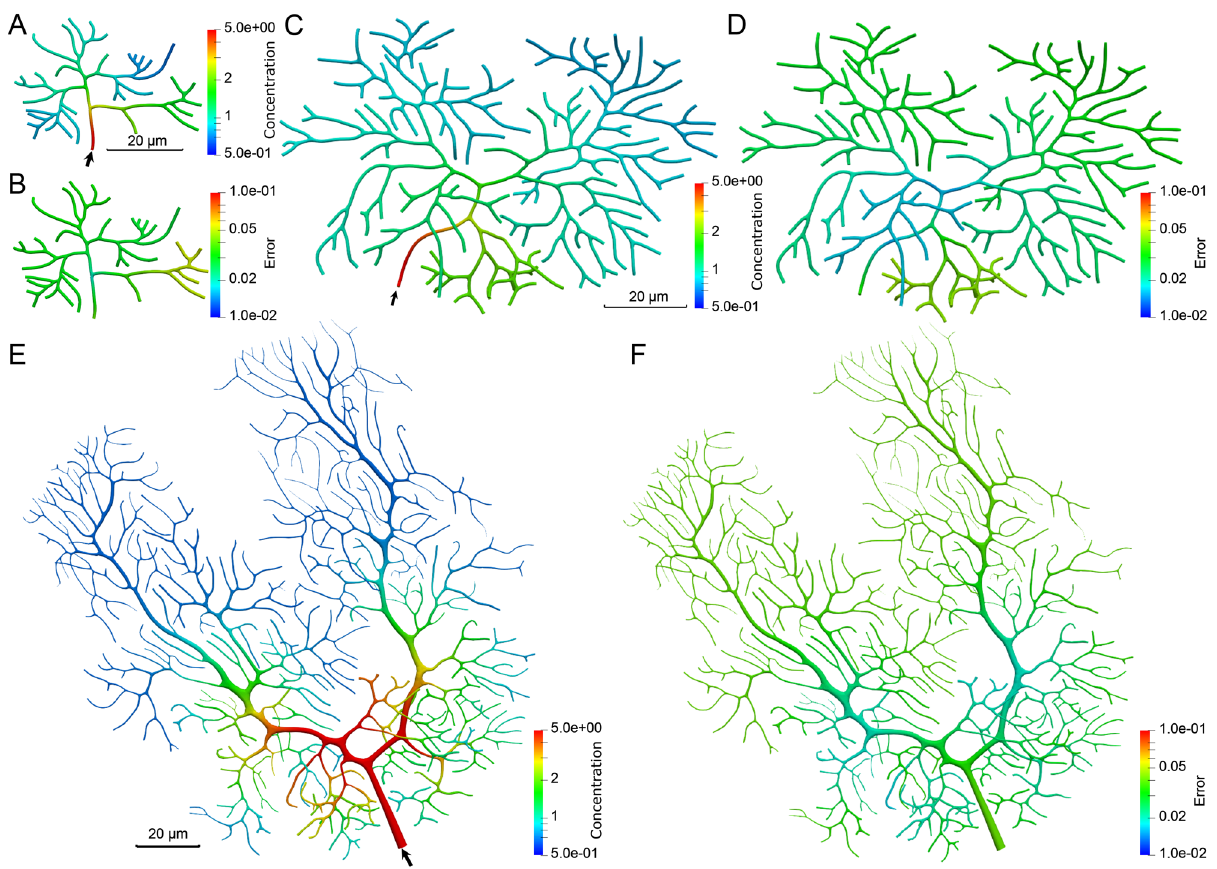
Figure 5. The concentration prediction of material transport in the neurite network geometry of NMO_54504, NMO_54499 and NMO_00865. ( A , C , E ) The predicted concentration results of steady state at t = 12 s , 41 s , and 63 s , respectively. The black arrows point to the inlet of material. Scalar bar: 20 µ m . Unit for color bars: mol /µ m 3 . ( B , D , F ) The nodal errors between the ground truth and predicted concentration. Logarithmic scale is used to highlight the distribution pattern.